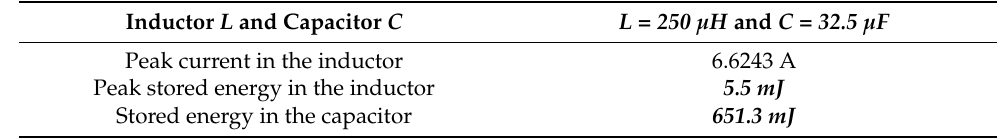
Table 1. Conventional boost converter design.